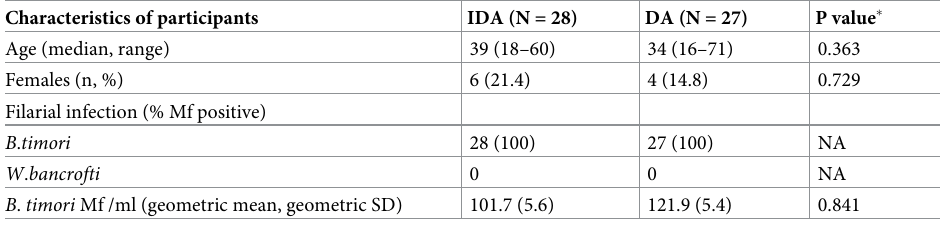
� Mann-Whitney test for continuous variables and Fisher Test for categorical variables. NA, not applicable; SD, standard deviation, Mf, microfilaria.